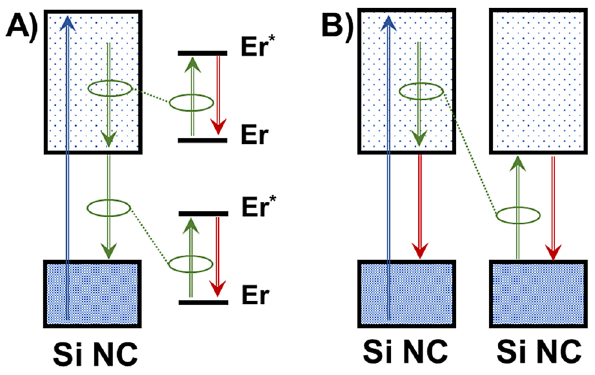
Figure 4: (A) Quantum cutting process for Er-doped Si